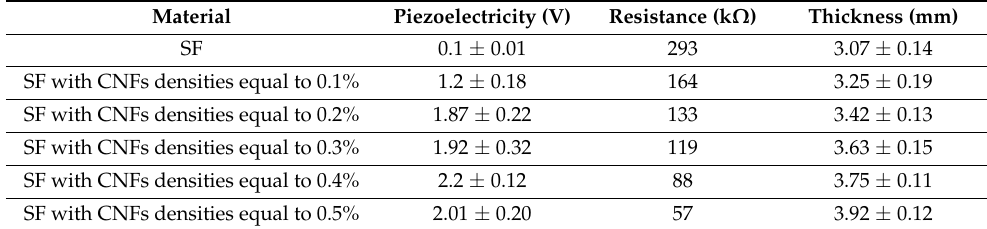
Table 1. The voltage response of SF with different CNFs